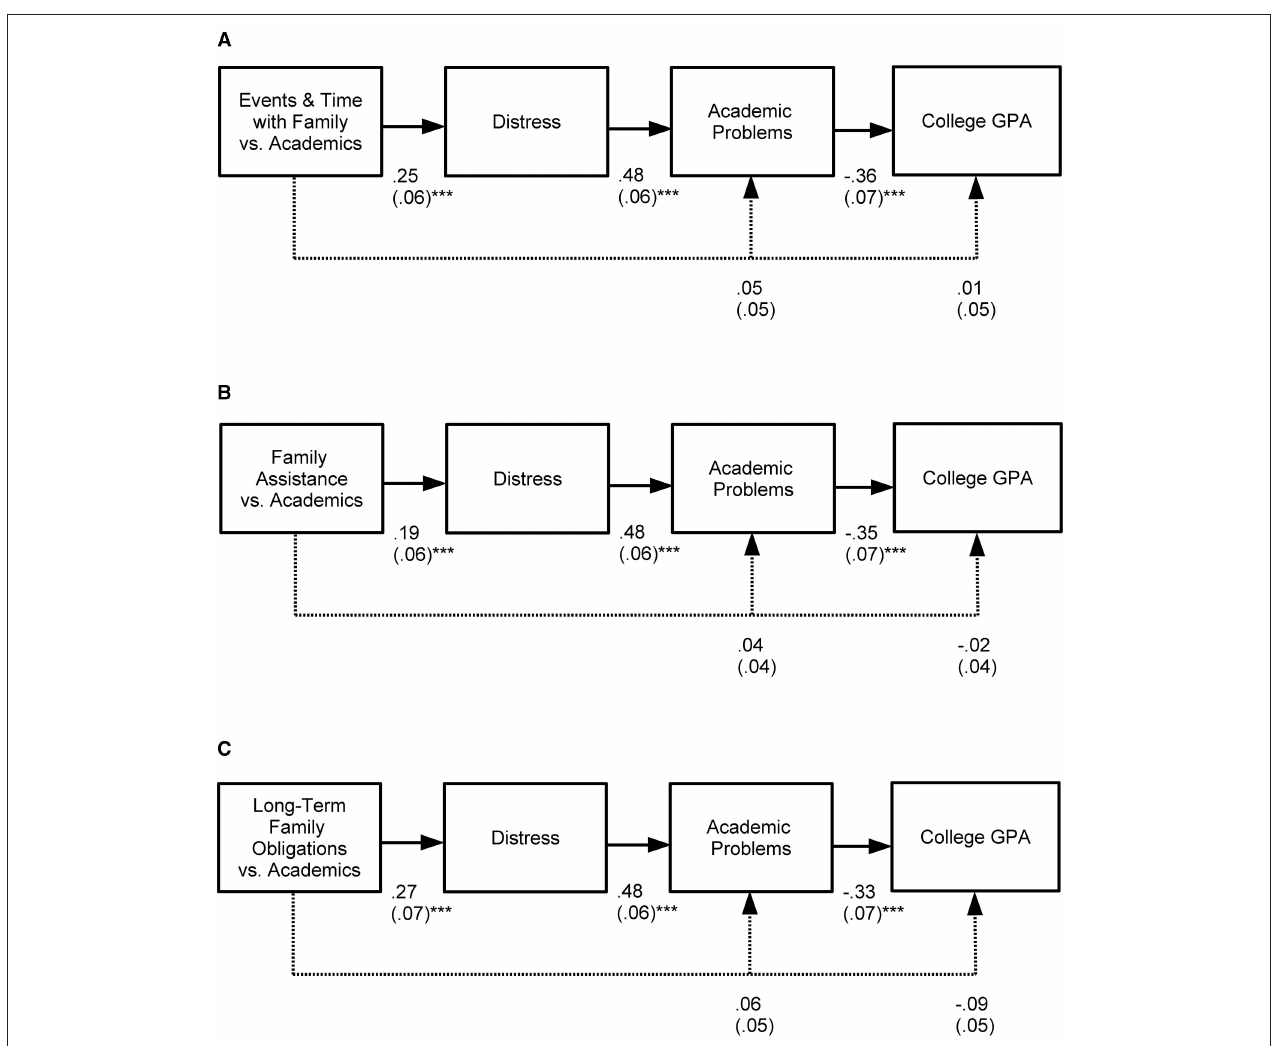
FIGURE 4 | Consequences of the three forms of home-school cultural value mismatch: (A) events and time with family, (B) family assistance, and (C) long-term family obligations vs. academics. Included are unstandardized estimates (with standard errors); a solid line indicates significance and a dashed line indicates non-significance; *** p <